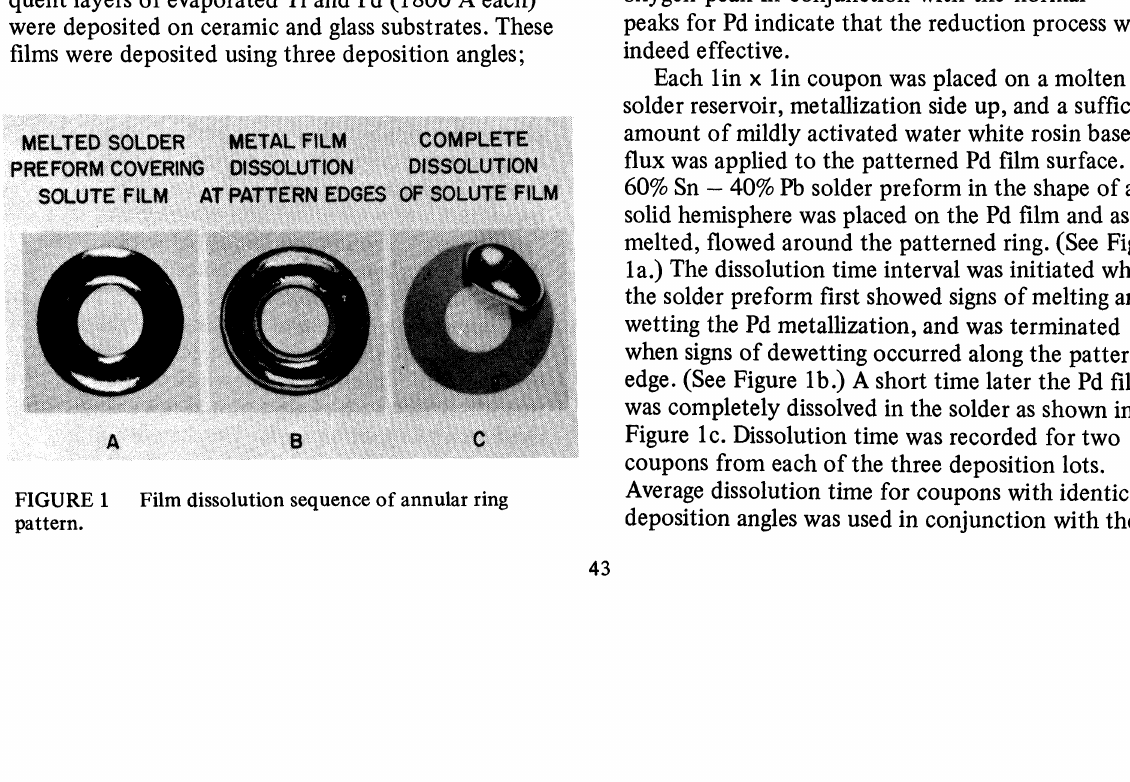
FIGURE Film dissolution sequence of annular ring pattern.